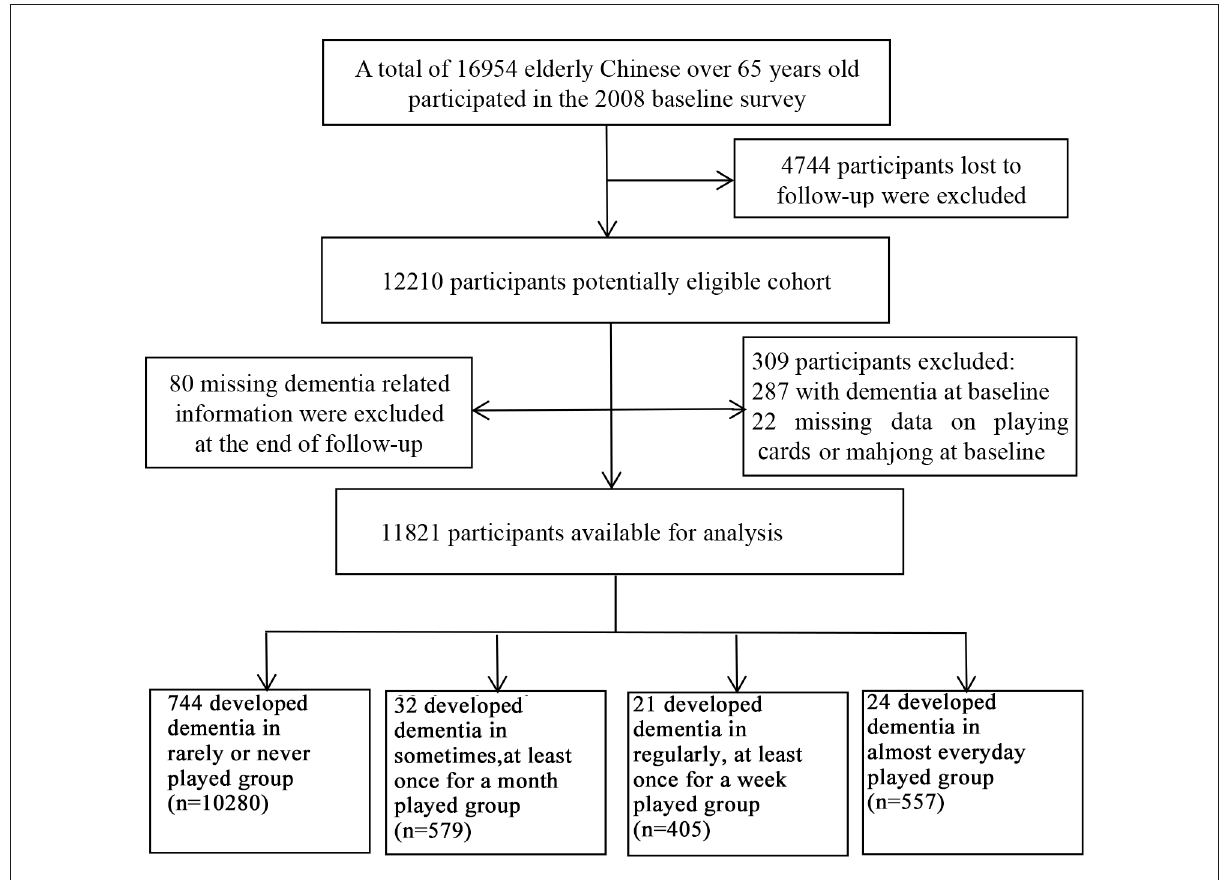
FIGURE1 Flow chart of the study